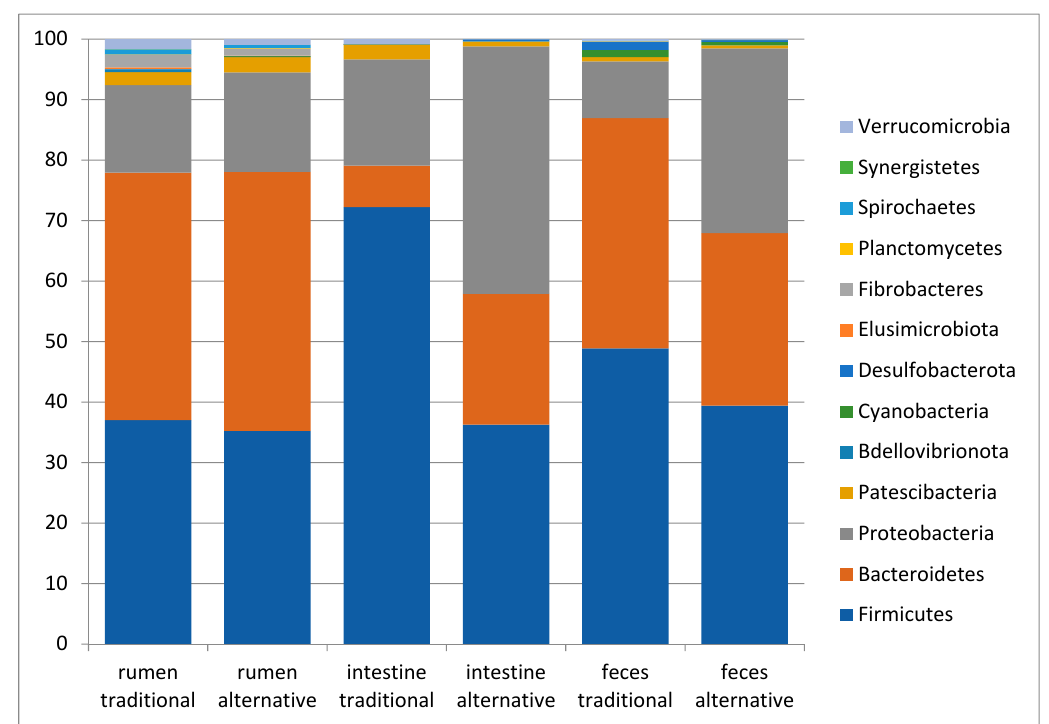
Figure 5. Taxonomy bar plots at Phylum level of the rumen, large intestine and feces from traditionally fed water buffaloes ( n = 10). Relative abundance (mean relative frequency) of the bacterial Phyla identified in different GIT sites (rumen, large intestine and feces) from traditionally ( n = 10) and alternatively ( n = 10) fed water buffaloes.